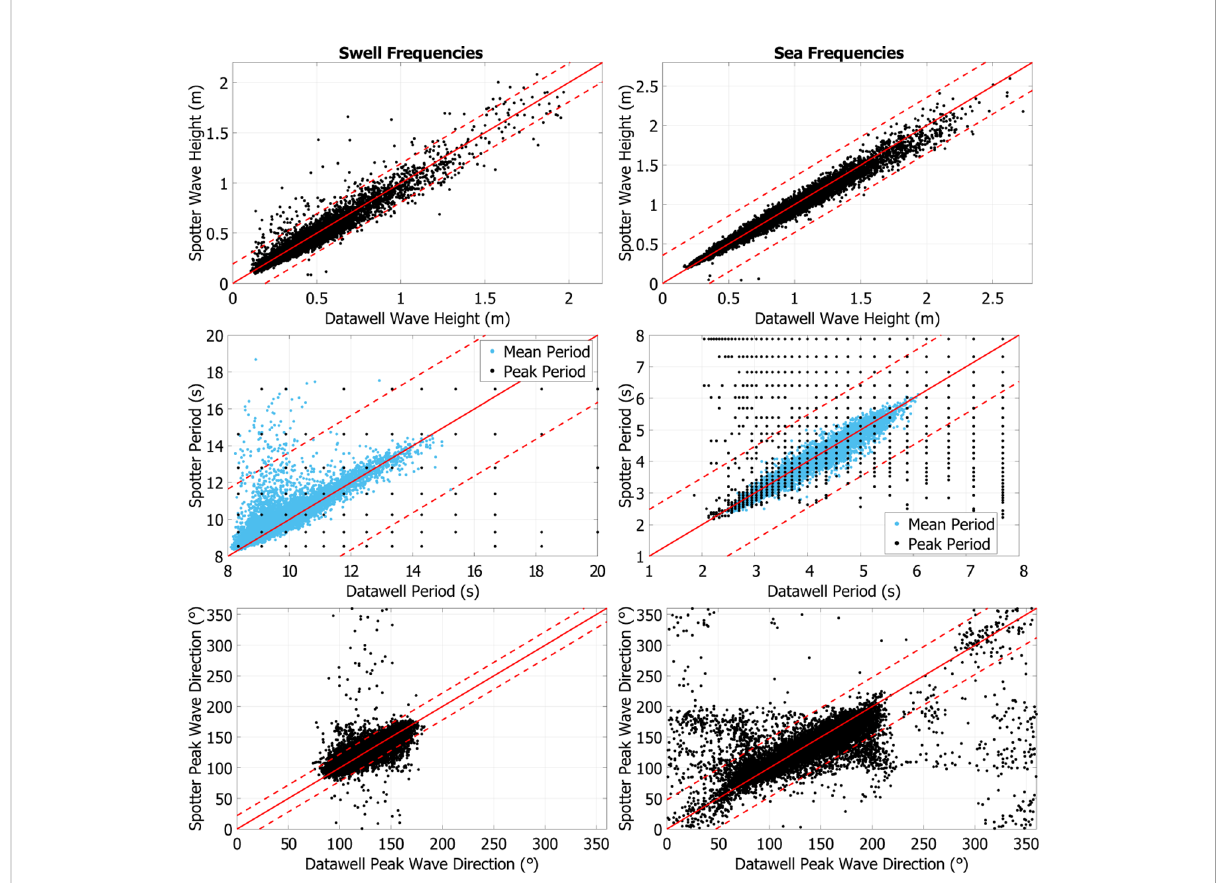
FIGURE 5 Scatter plots of signi fi cant wave height (top row), peak period and mean period (middle row), and peak wave directions (bottom row) calculated for swell frequencies (left column) and sea frequencies (right column) of the Datawell and Spotter wave buoys. The solid red line through the origins shows a 1:1 relationship between the two buoys; the dashed red lines show one standard deviation for the Datawell from the 1:1 line. For the middle row, the dashed red lines show one standard deviation for Datawell reported peak periods from the 1:1